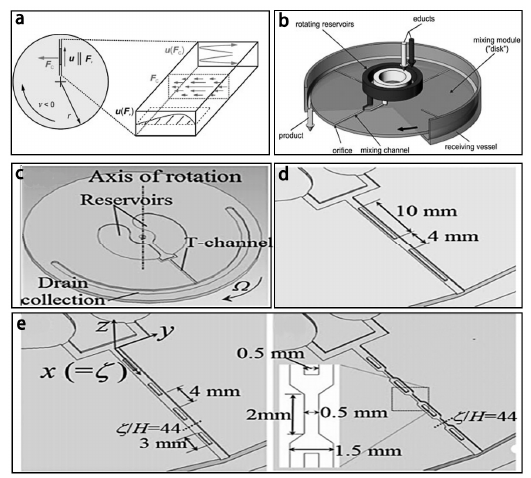
Figure 10. ( a ) The force analysis: F c is the Coriolis force, F v is the centrifugal force, u(F c ) is the transverse of fluids; ( b ) Schematic of the centrifugal mixer; ( c ) Schematic of the microchannels; ( d ) with two obstructions; and ( e ) with four obstructions. Reproduced with permission from [90,91].